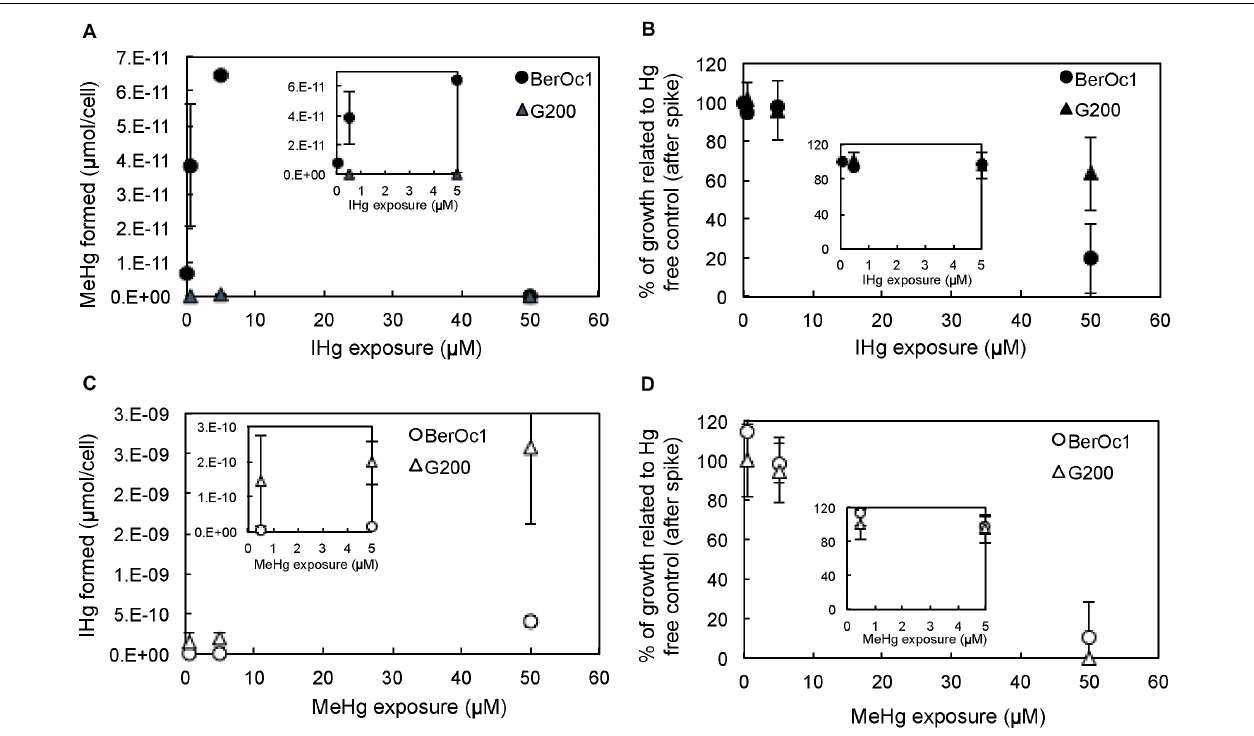
FIGURE 1 | MeHg production by BerOc1 and G200 (A) , and their cell growth (B) , IHg production by BerOc1 and G200 (C) and their cell growth (D) depending on IHg (A,B) and MeHg (C,D) exposure. Error bars correspond to standard deviation calculated on results from two or three replicates. Insets correspond to zooms on the smallest IHg and MeHg exposures (from 0.05 to 5 µ